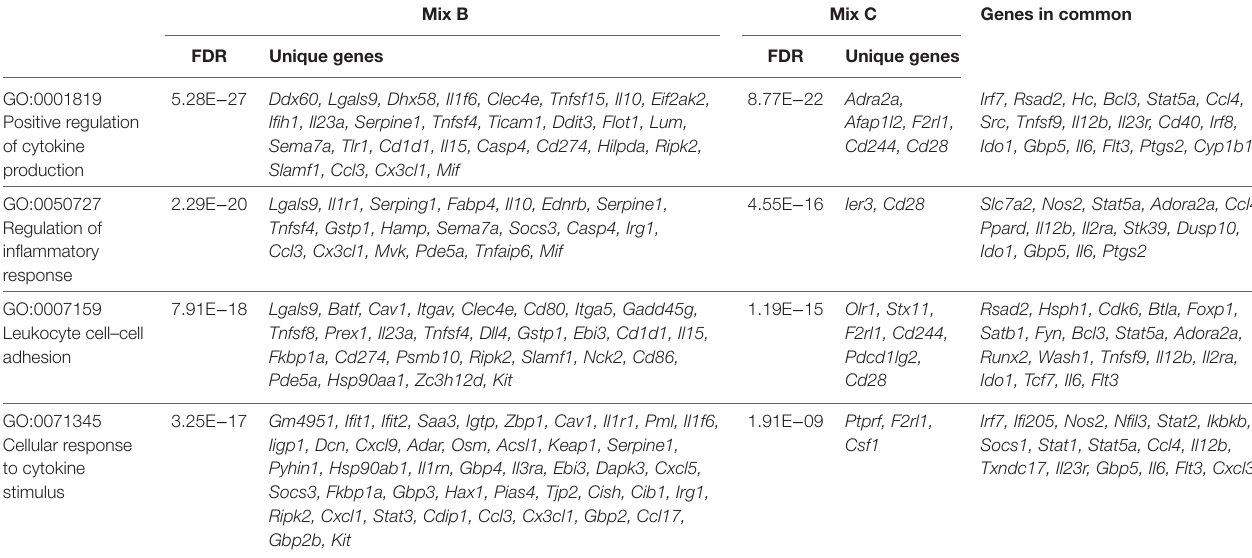
TaBle 4 | Unique or common upregulated genes in dendritic cells stimulated with mix B or mix C that enriched GO terms related to immune response. Mix